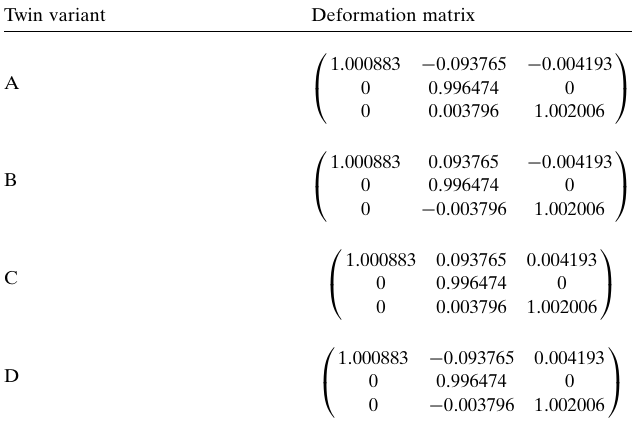
Table 2 Deformation gradient tensors of four variants of the same group from the (1 0 1) A plane [(1 0 1) A group], represented in the frame referring to [1 0 (cid:5) 1] A –[1 0 1] A –[0 (cid:5) 1 0] A . Twin